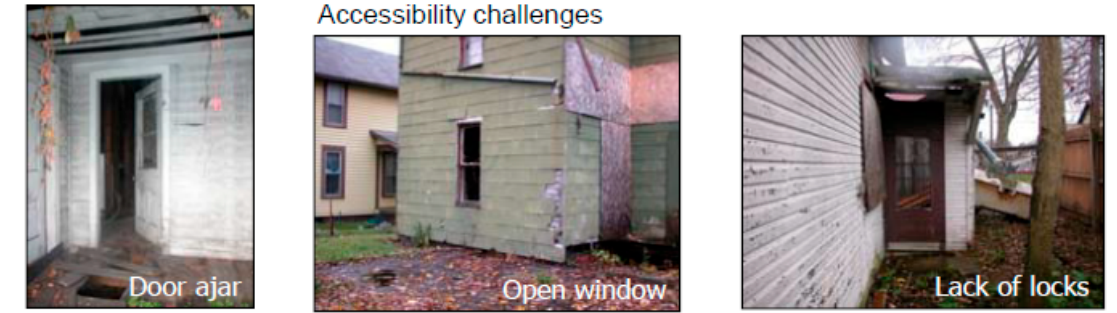
Figure 6. Examples of accessibility cues among abandoned houses in Newark, Ohio. Photography: K. Sandin.